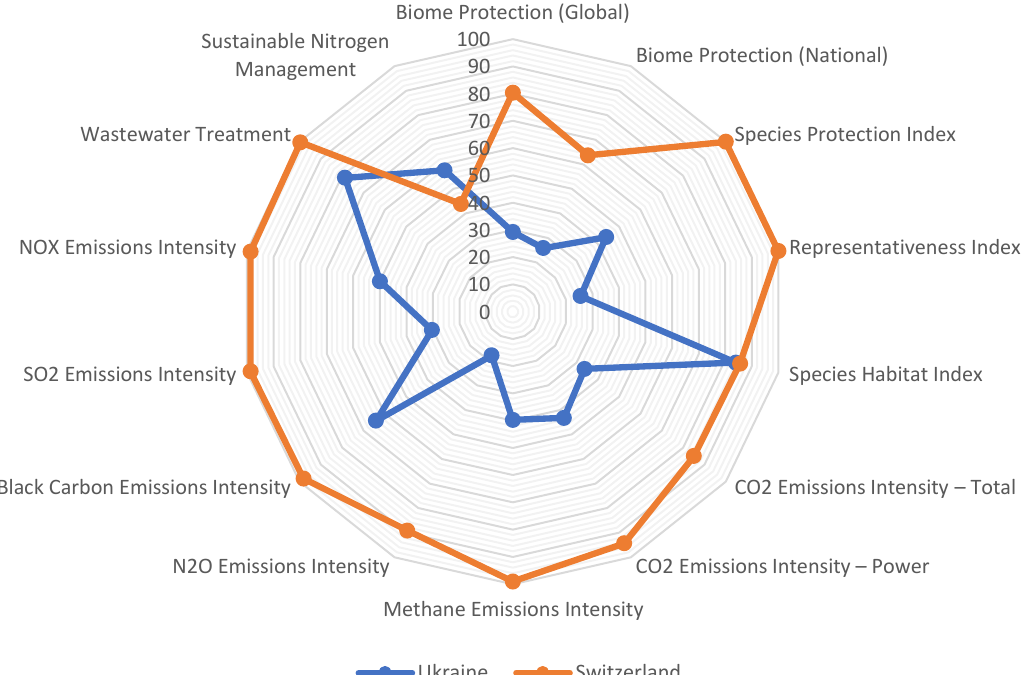
Figure 3. Comparative analysis of ecosystem vitality between Switzerland and Ukraine